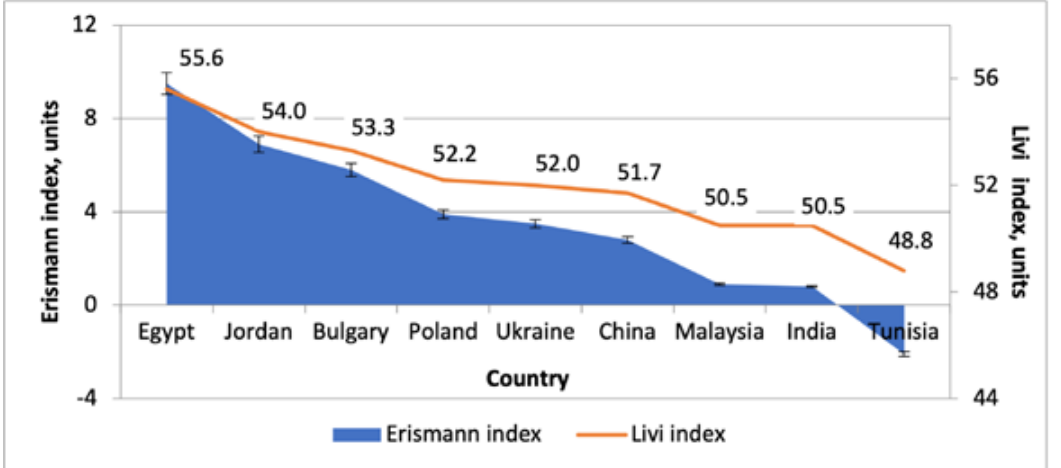
Figure 3. Erismann and Livi index values for students depending on ethnicity ratios of fat, bone and muscle tissue in the body of students are shown in Fig.